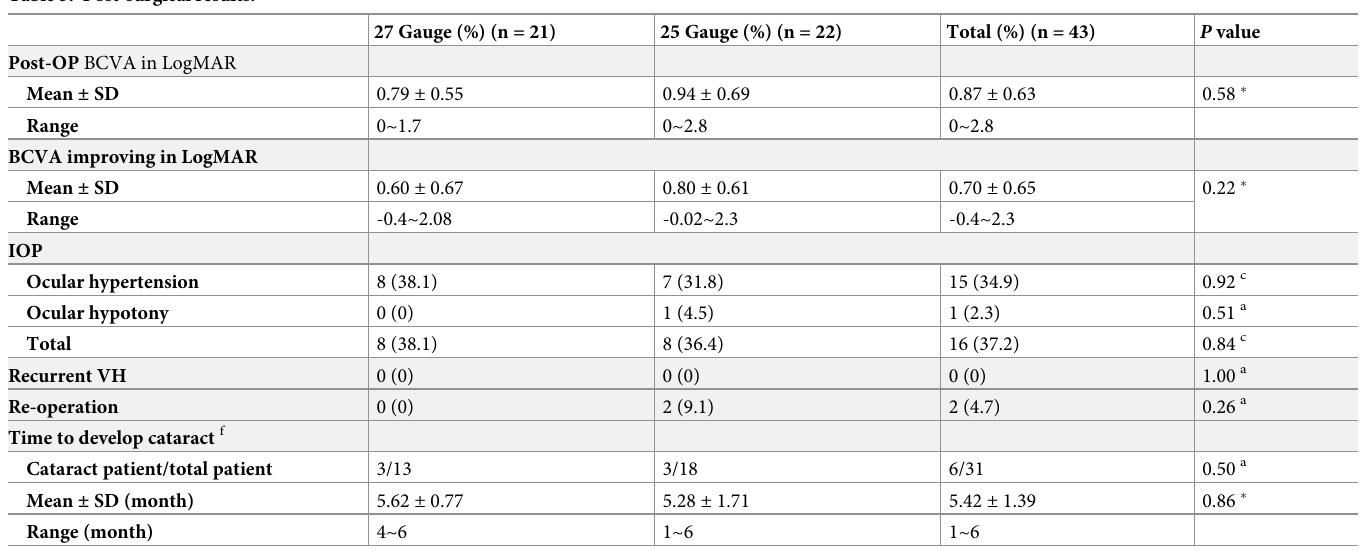
Table 3. Post-surgical results.